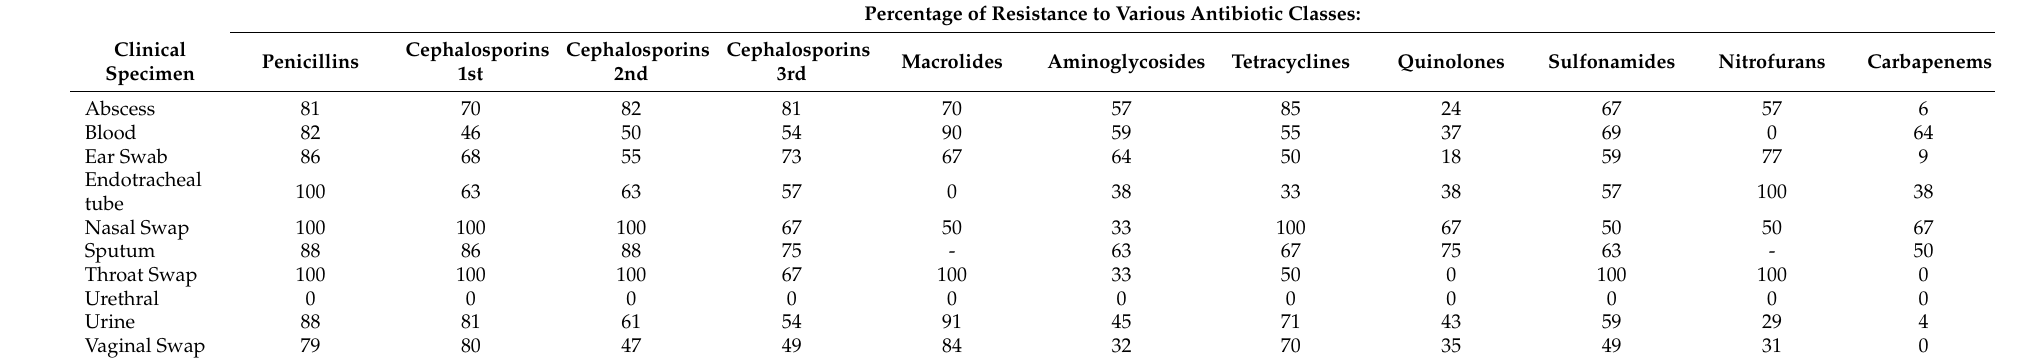
Table 1. Summarizes the percentage antibiotic resistance patterns for strains isolated from various clinical specimen